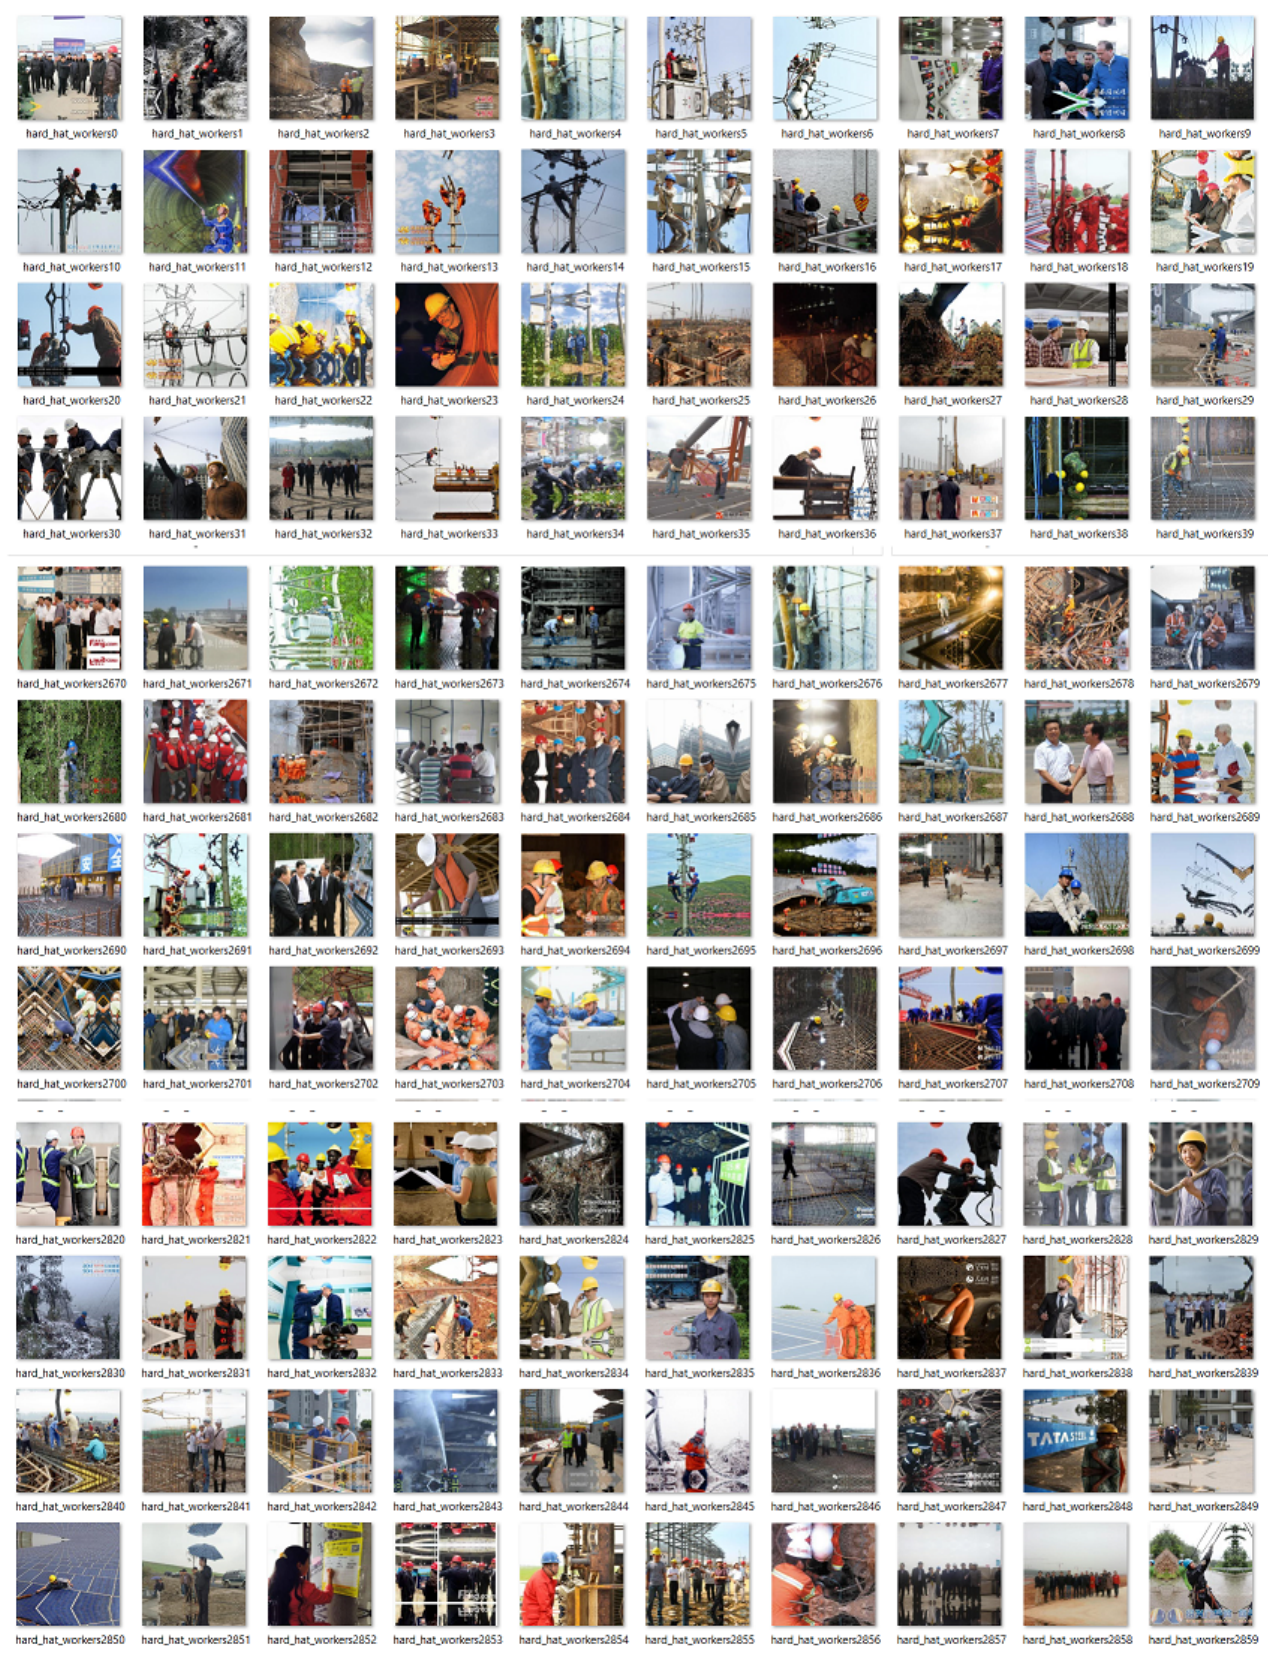
Figure 2. Sample images of the SHEL5K